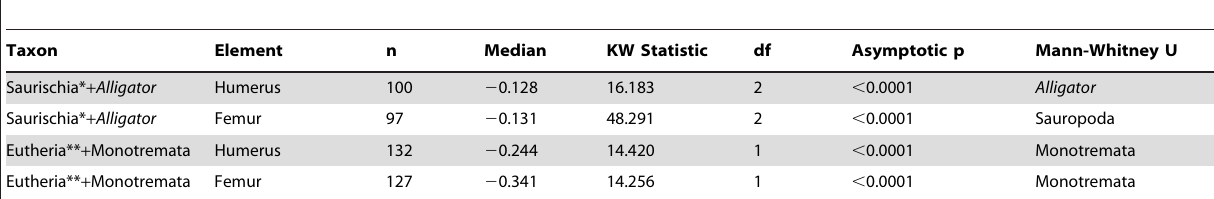
Table 3. Kruskal-Wallace and pair-wise Mann-Whitney U non-parametric tests for significant differences in maximum shape change (PRIN 1) among the postures of the sampled taxa based on the median score of PRIN 1.